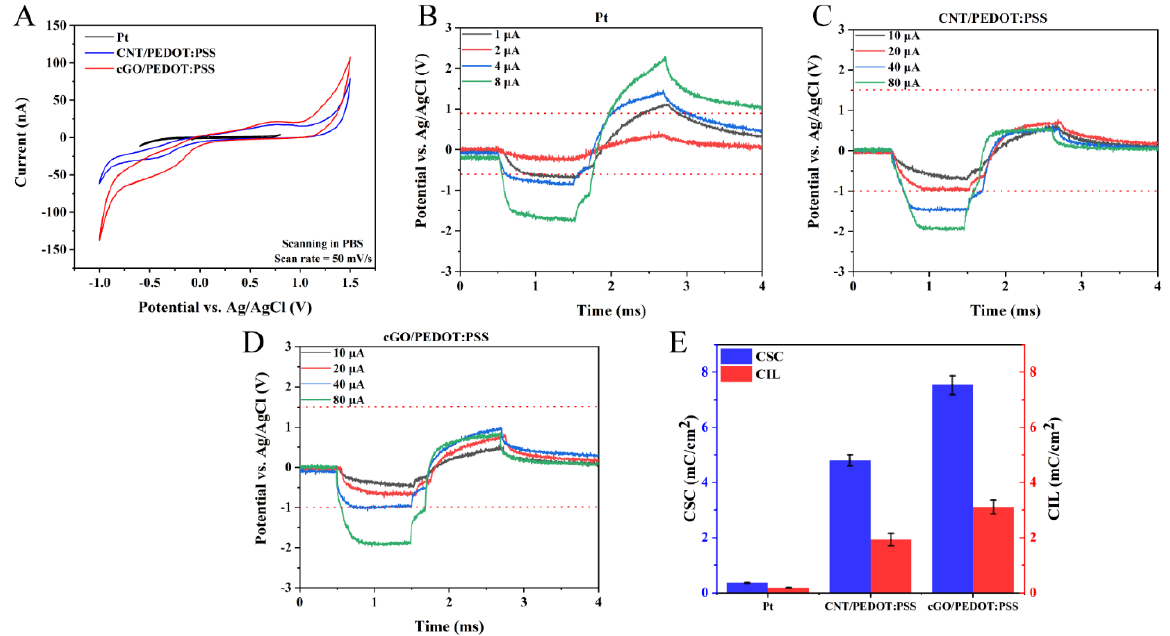
Figure 3. The stimulation performance of the neural sensor. ( A ) The CSCs of Pt ‐ , CNT/PEDOT:PSS ‐ , and cGO/PEDOT:PSS ‐ coated electrodes were measured by CV. ( B ) Measurement of CIL of Pt elec ‐ trodes via the voltage transient method. ( C ) Measurement of CIL of CNT/PEDOT:PSS ‐ modified electrodes. ( D ) Measurement of CIL of cGO/PEDOT:PSS ‐ modified electrodes. ( E ) CSC and CIL of Pt, CNT/PEDOT:PSS and cGO/PEDOT:PSS ( n = 5).